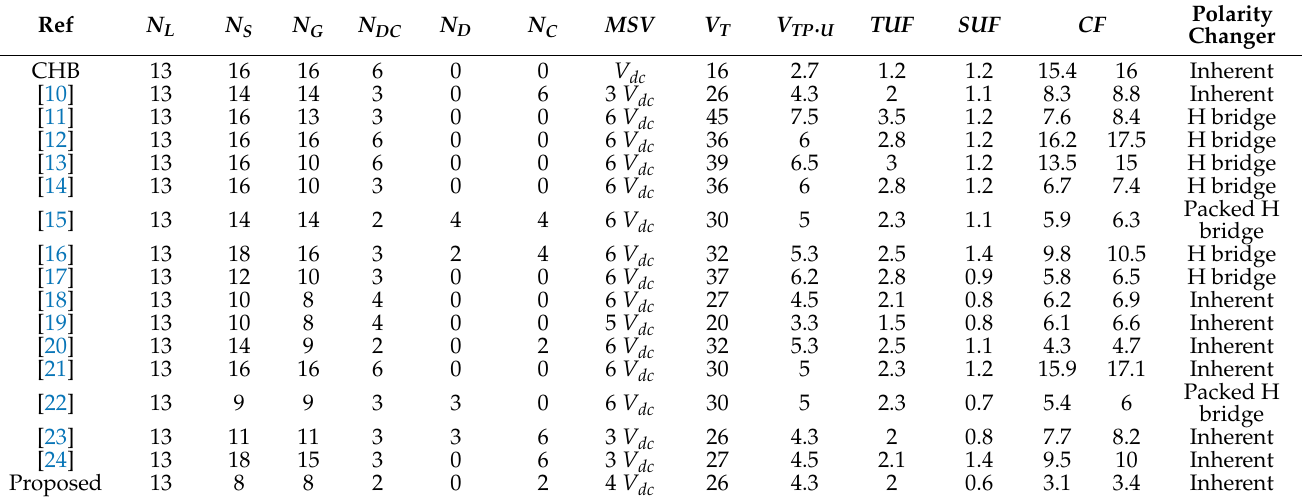
Table 2. Comparison of various parameters, which includes cost function for 13-level inverter